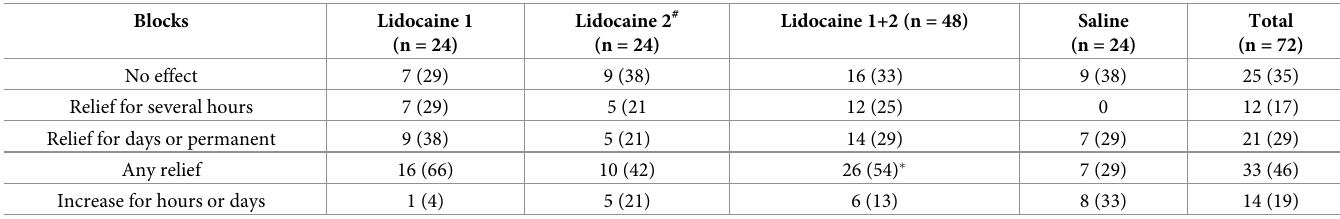
Table 2. Summary of the different effects of the three blocks on